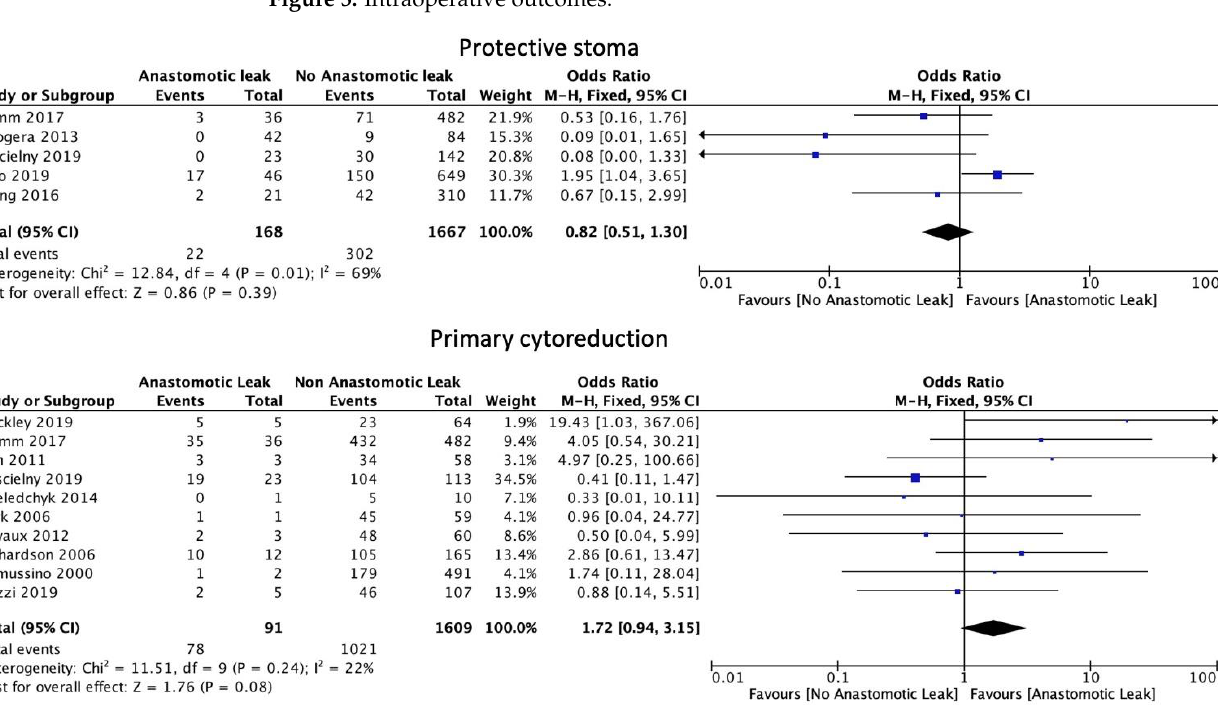
Figure 6. Stoma formation and primary cytoreduction risk factors.